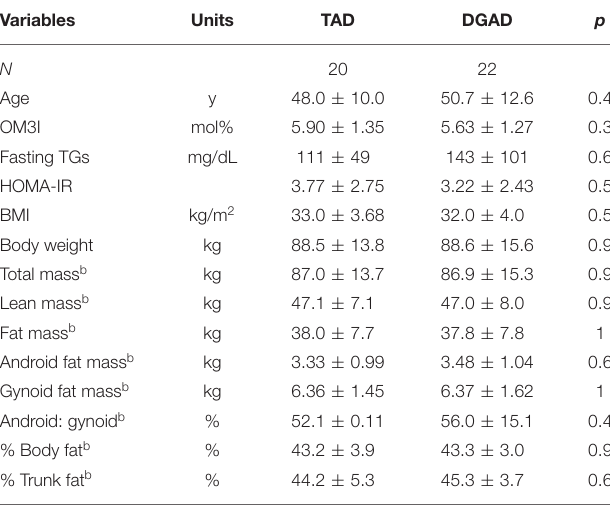
TABLE 1 | Study cohort baseline clinical and body composition characteristics a